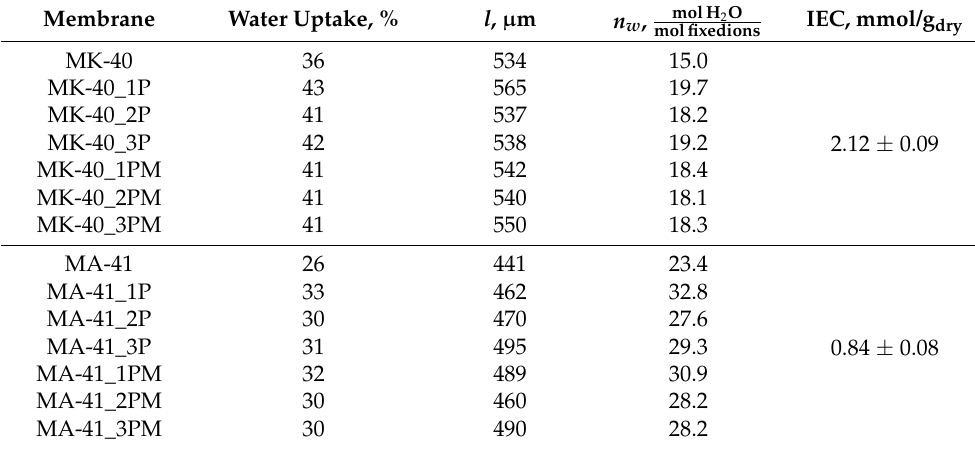
Table 1. The physical-chemical properties of initial and profiled single layer and bilayer membranes. Membrane Water Uptake, %